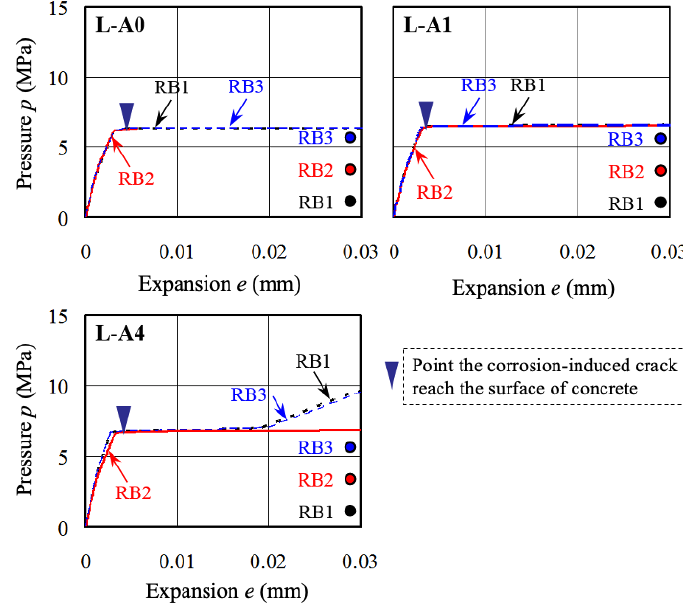
Figure 13. Relationship between average internal pressure and expansion according to the location of steel bars for each specimen.